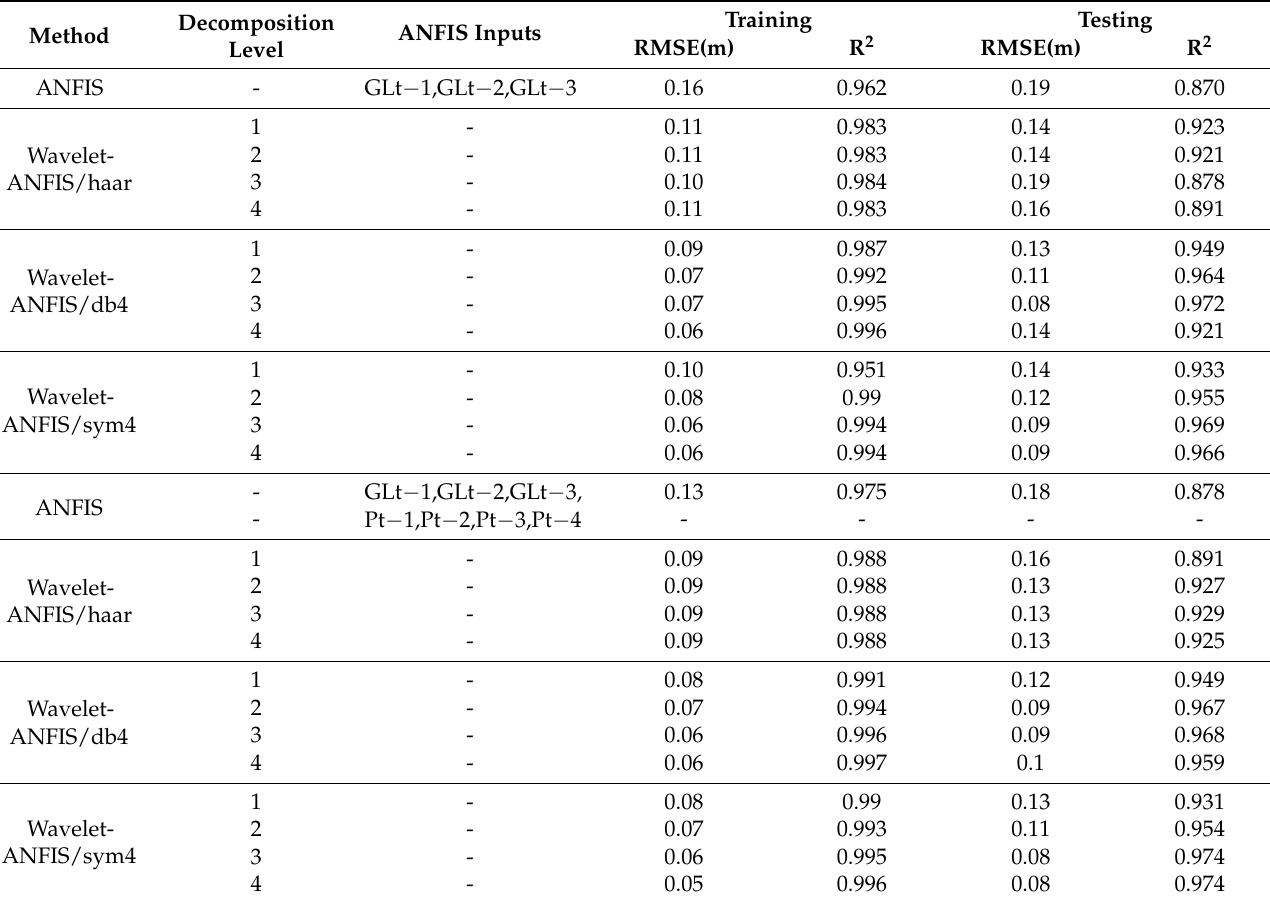
Table 3. Results of the various model combinations of input data with the optimum number of clusters ( c = 2) for the training and testing phases of